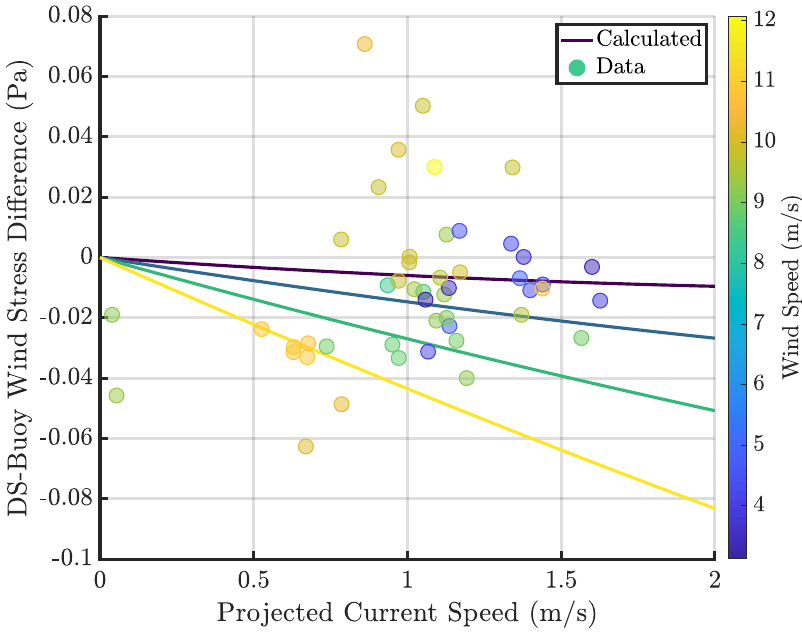
Figure 14. Difference between DopplerScatt measured and buoy measured wind stress plotted against wind-direction projected surface current